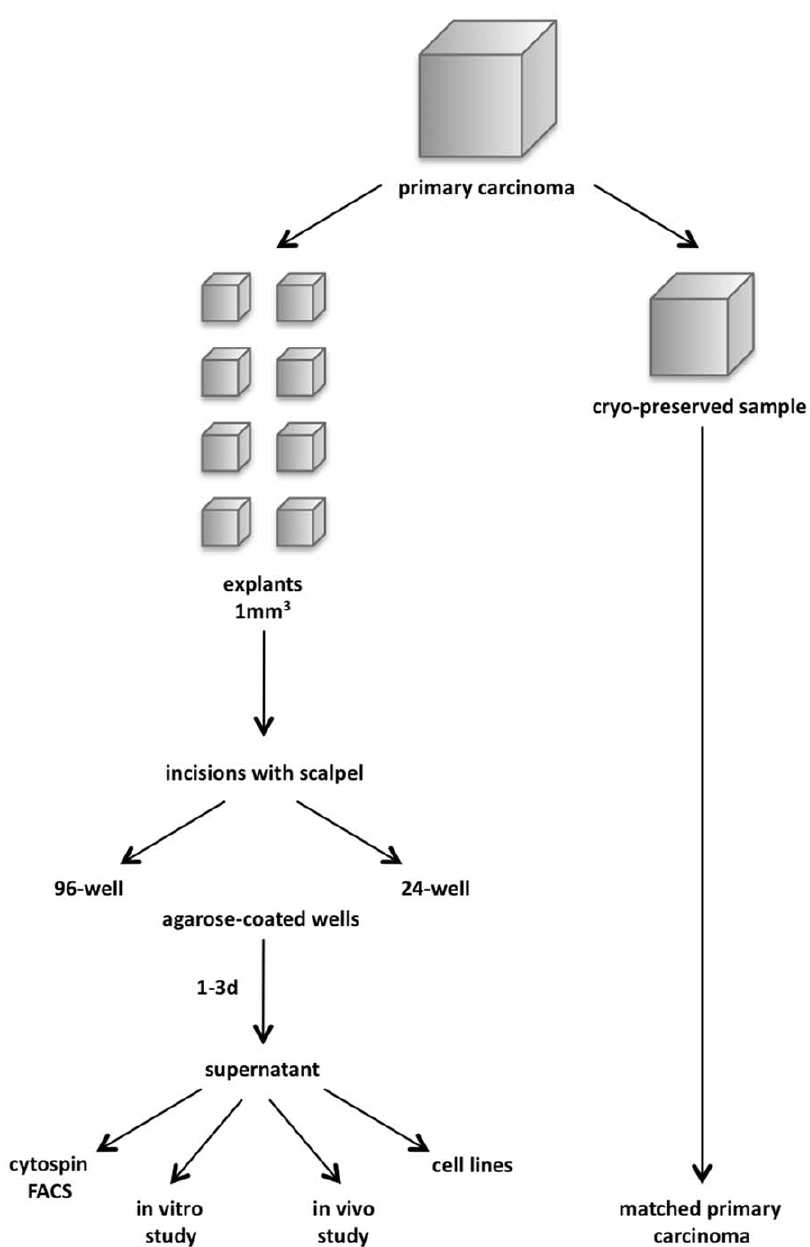
Figure 1. Schematic representation of the method of tumour explant formation. Specimens of primary carcinomas ( . 5 mm 3 ) are cut into approximately 1 mm 3 cube-like structures termed explants. One part of the primary carcinoma is cryo-preserved as a matched control for explanted cells. Incisions are generated in explants, which are then transferred into agarose-coated 96- or 24-well plates for a time period of 1–3 days. Supernatants are collected and cells harvested upon centrifugation for subsequent analysis or